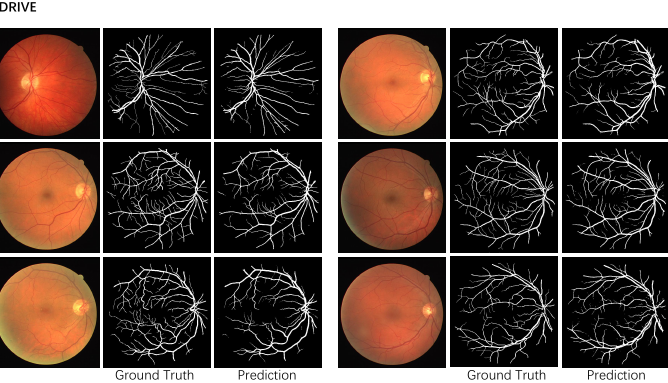
Figure 3. The segmentation example of the proposed method on the DRIVE dataset.